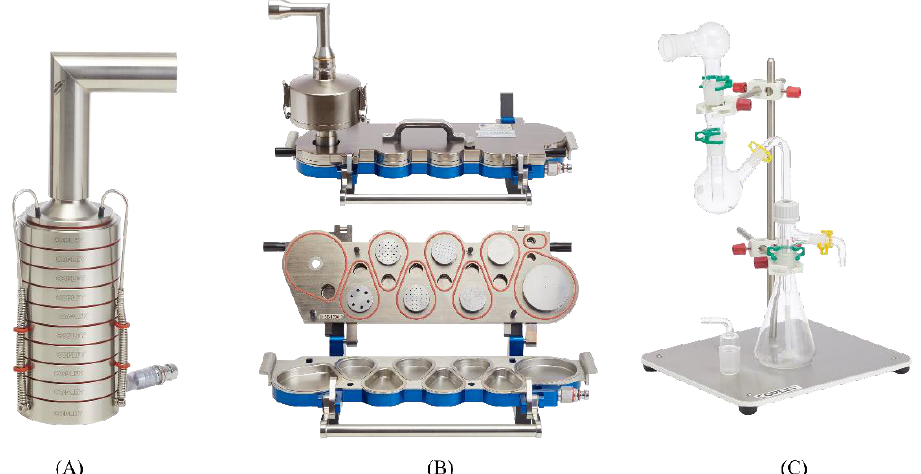
Figure 2. Various approaches to collect fine particle dose (FPD). ( A ) Andersen Cascade Impactor (ACI), ( B ) Next Generation Impactor (NGI; top- closed view and bottom- open view of NGI), and ( C ) Twin Stage Impinger (TSI). Figures ( A – C ) were reproduced with permission from Driving Results in Inhaler Testing [Brochure, 2020 edition] [46], Copley Scientific Limited. Table 1. Summary of the fine particle dose (FPD) collection methods for dissolution testing of dry powder particles.